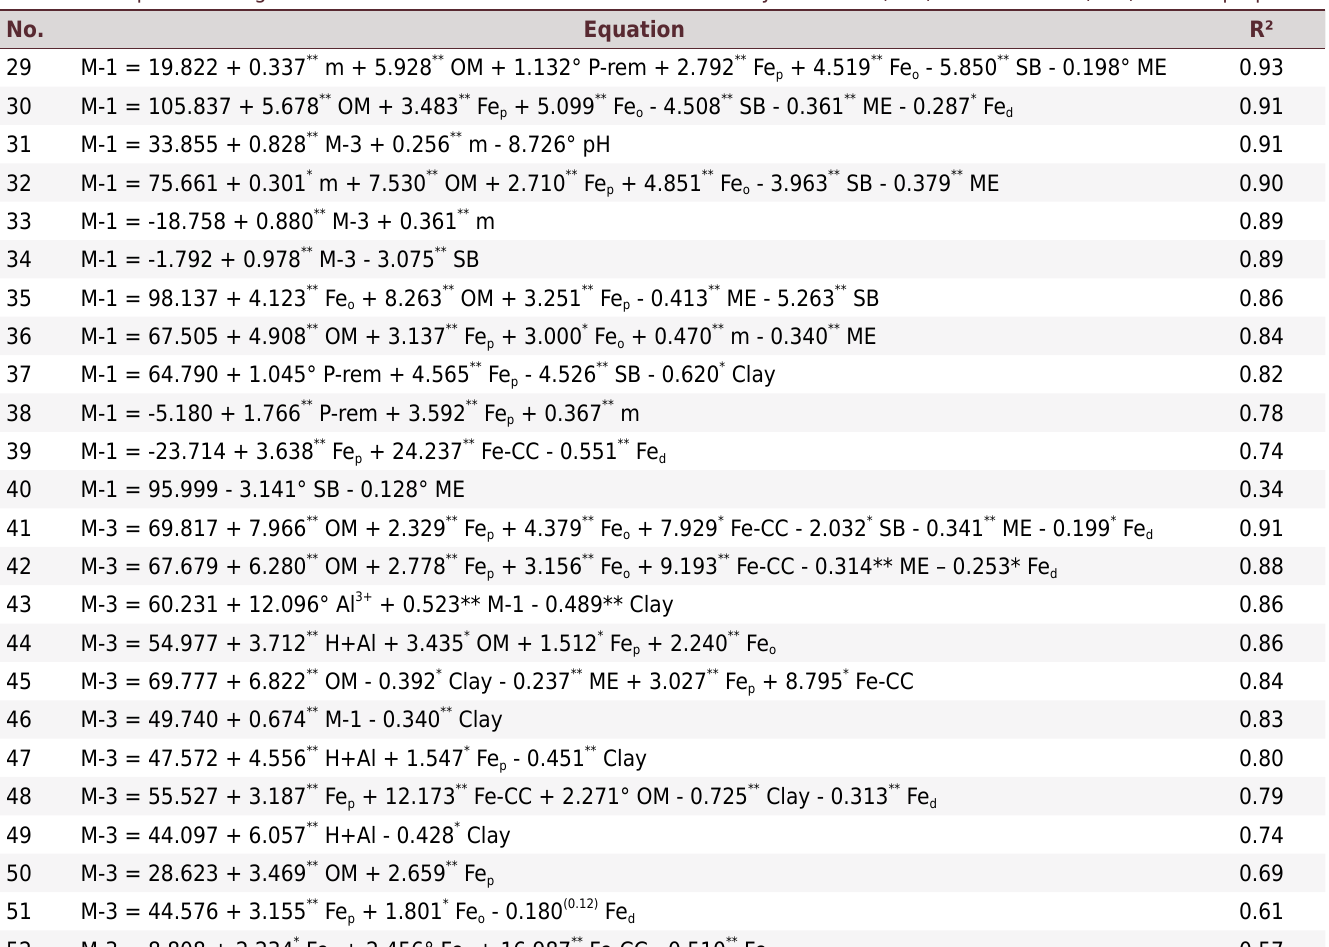
Table 5. Multiple linear regression between the Fe concentrations obtained by Mehlich-1 (M-1) and Mehlich-3 (M-3) and soil properties No.